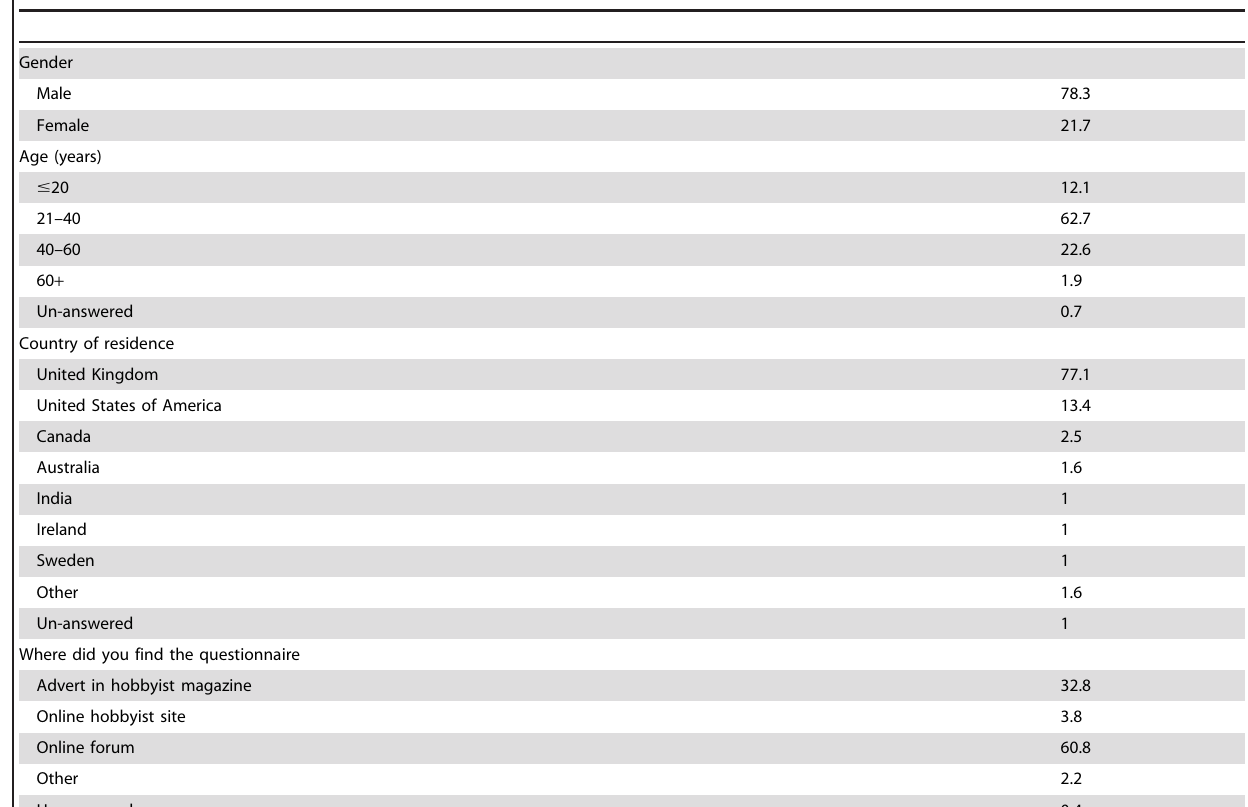
Table 1. Survey sample